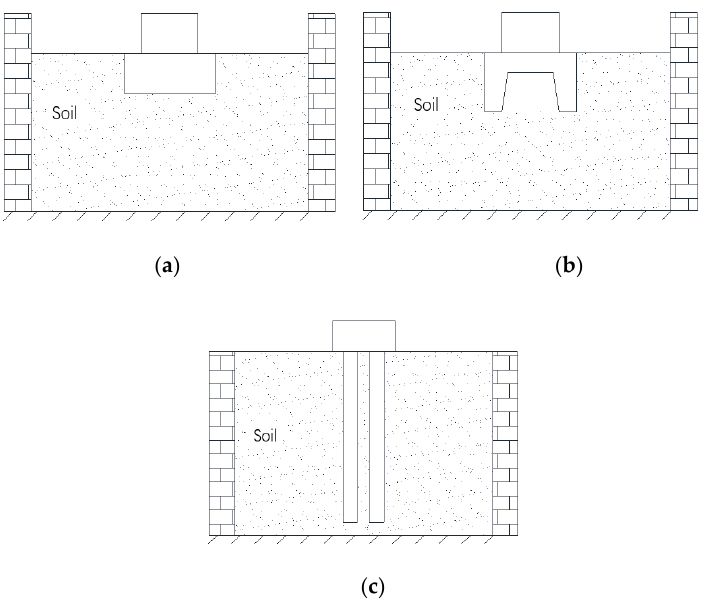
Figure 5. Cross-sectional views of the sand tank configurations in the laboratory: ( a ) spread foun- dation; ( b ) caisson foundation; ( c ) grouped pile foundation.